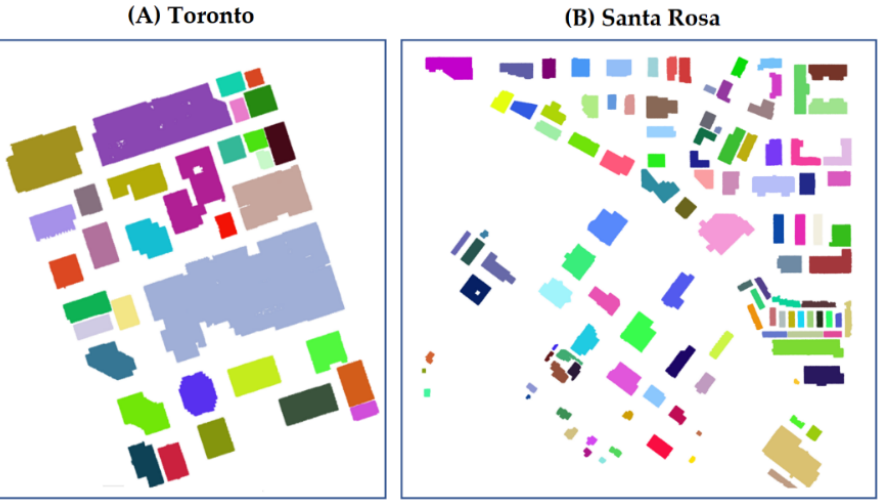
Figure 14. Points colorized according to its cluster id. Each cluster represents a building. ( A ) To- ronto; ( B ) Santa Rosa. ( B ) Santa